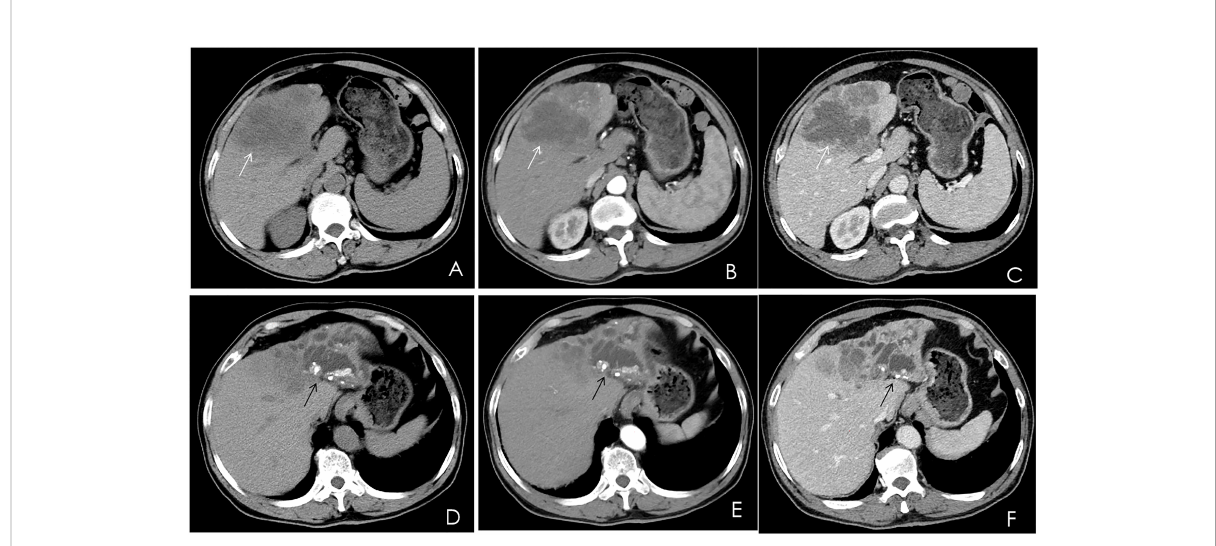
FIGURE 1 Multiphase contrast-enhanced CT of the upper abdomen, axial view. (A) A noncontrast CT showed multiple low-density masses and nodular mixed-density shadows in the left lobe and part of the anterior right lobe of the liver (white arrow). (B) The arterial phase showed heterogeneous ring enhancement (white arrow). (C) The venous phase showed continuous enhancement (white arrow). (D – F) The left branch of the intrahepatic bile duct and its branches were dilated, and high-density nodular shadows were seen in the liver (black